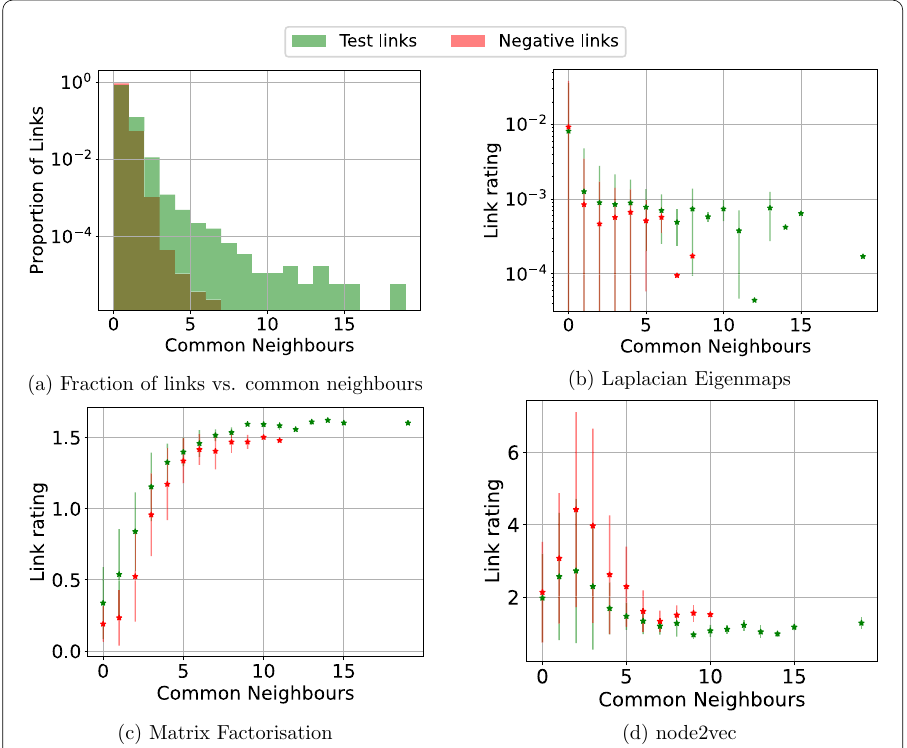
Fig. 2 a Fraction of links of the generated networks ( γ = 2.50 , β = 0.60 ) that share a given number of neighbours. Average rating of negative and test links with a given number of common neighbours derived by b Laplacian Eigenmaps, c Matrix Factorisation, and d